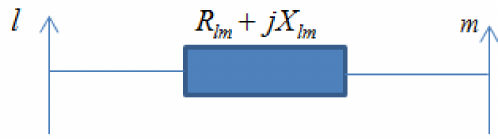
Figure 1. Illustration of the distribution